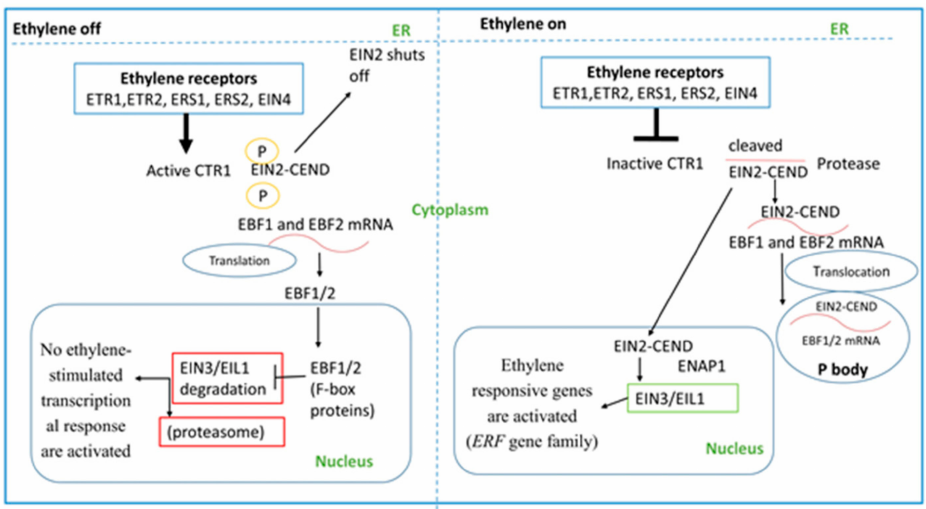
Figure 3. Mechanism of the ethylene signaling pathway in plants. Ethylene receptors ETHYLENE RESPONSE1 (ETR1), ETR2, ETHYLENE RESPONSE SENSOR1 (ERS1), ERS2, and ETHYLENE INSENSITIVE4 (EIN4) are present on the endoplasmic reticulum (ER) membrane. In the absence of ethylene, ethylene receptors activate the CONSTITUTIVE TRIPLE RESPONSE1 (CTR1)